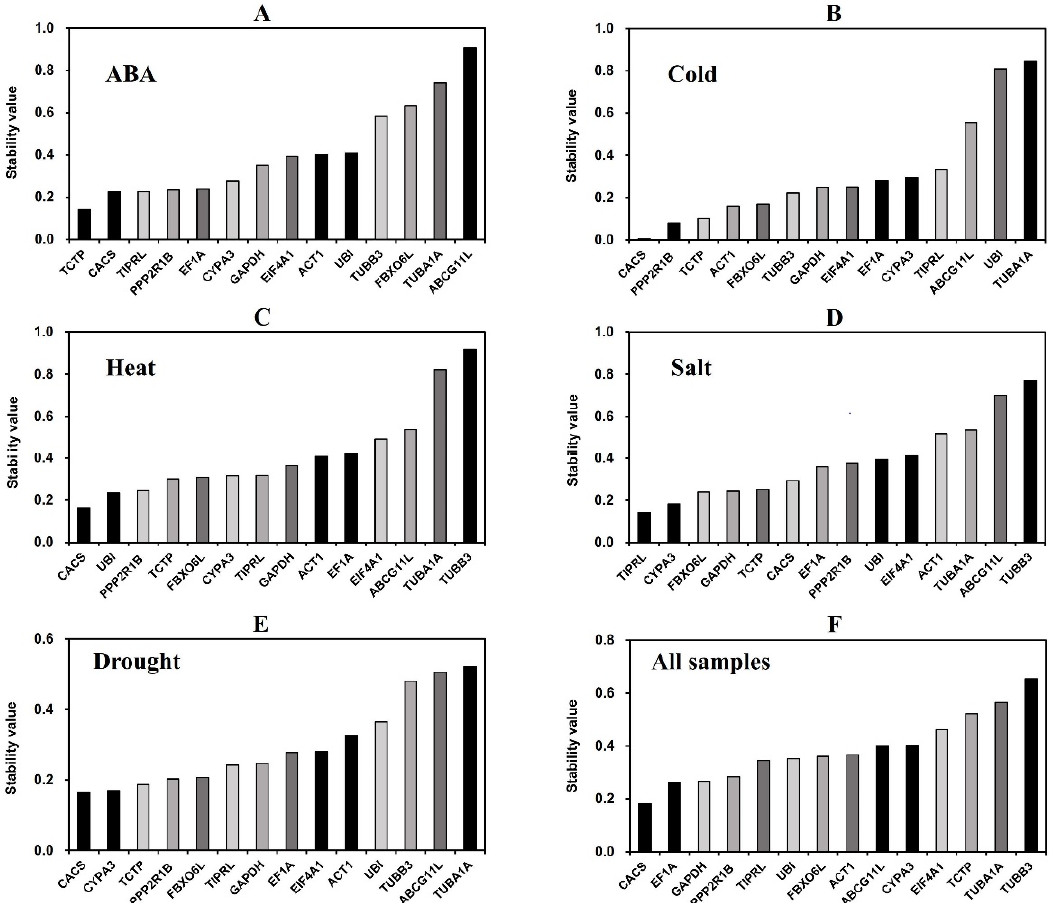
Figure 4. Expression stability of the fourteen candidate reference genes calculated using NormFinder.